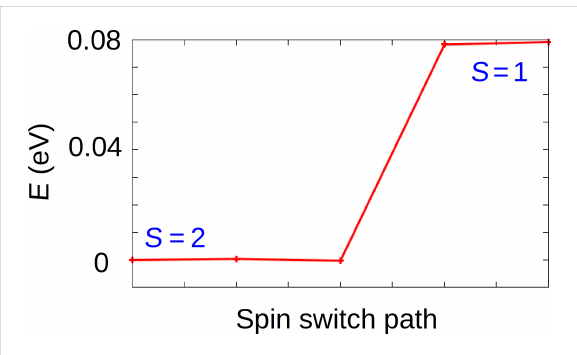
Figure 6: Calculated activation barrier between HS ( S = 2) and IS ( S = 1) of FeTPP ( C 2 h conformation) adsorbed at the hollow-fcc site of Au(111).